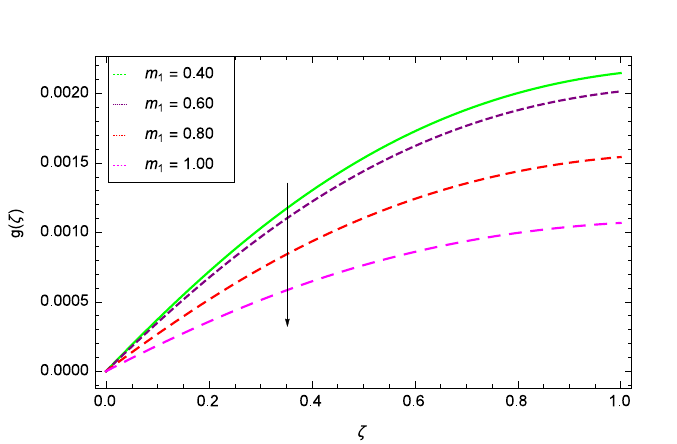
Figure 13. Parameter effect on velocity f ′ (ζ) profile.